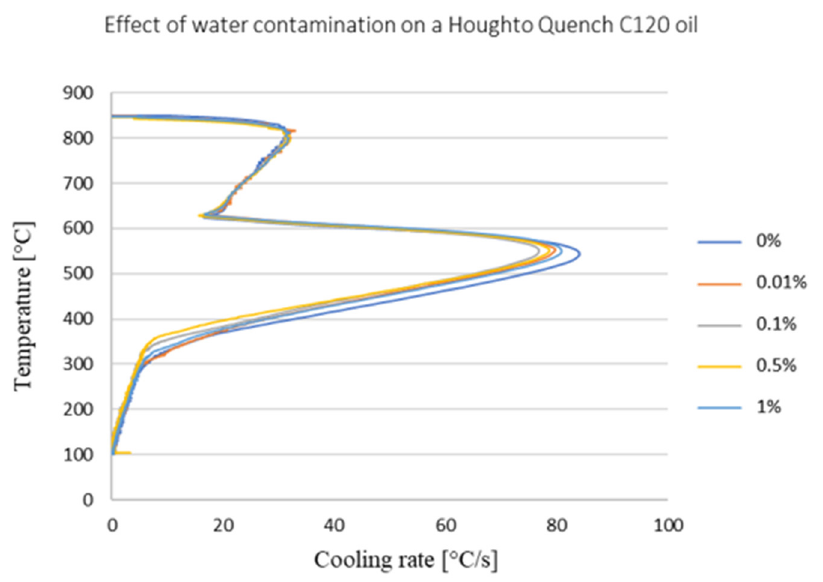
Figure 10. The effect of water level in Houghto Quench C120 oil on its hardening power (temperature-cooling curve).